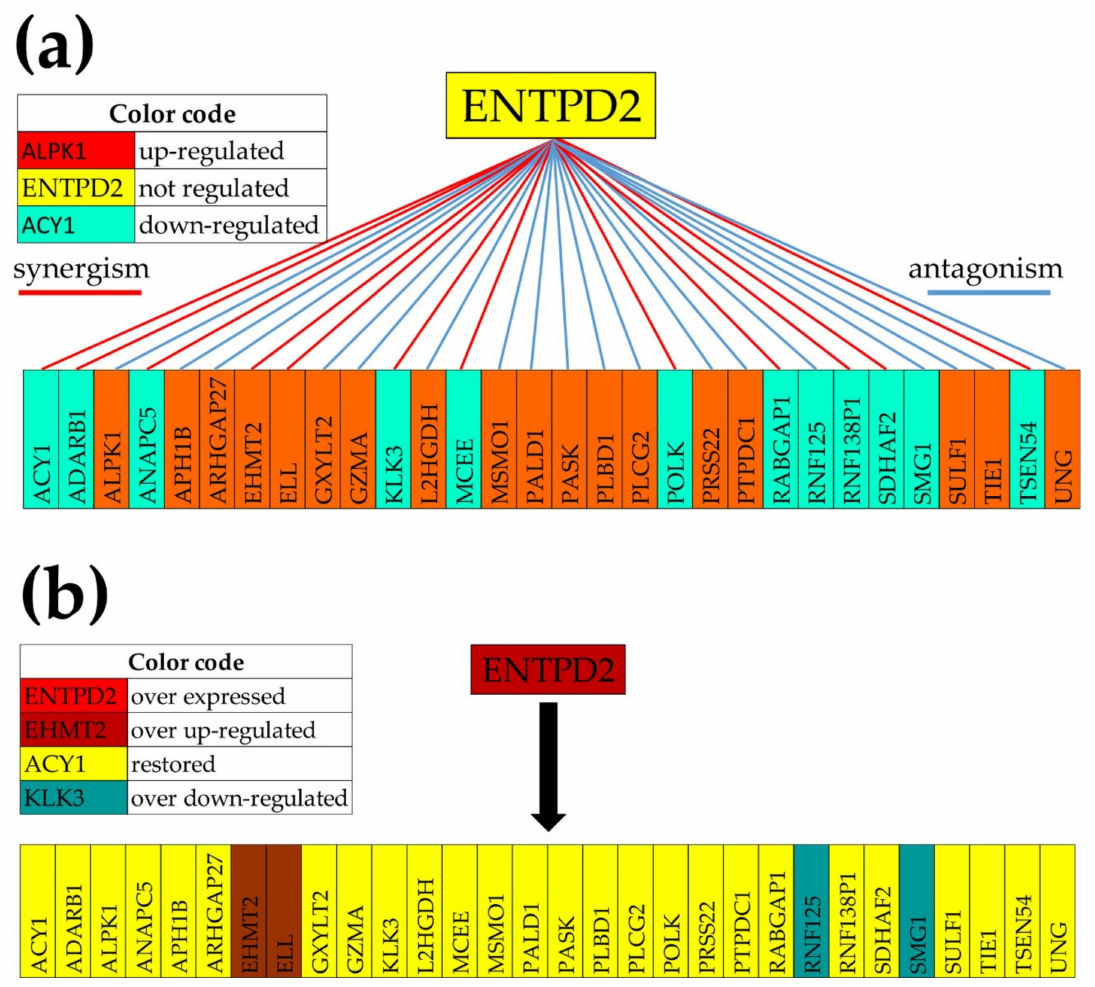
Figure 7. The GMR at work. ( a ) Significant expression coordination of the significantly regulated enzyme genes with ENTPD2 in “A”. ( b ) Expected regulation of the enzymes following overexpression of ENTPD2 . Note that all genes but EHMT2 (euchromatic histone-lysine N -methyltransferase 2), ELL (elongation factor RNA polymerase II), RNF125 (ring finger protein 125, E3 ubiquitin protein ligase), and SMG1 (SMG1 phosphatidylinositol 3-kinase-related kinase) restored their normal